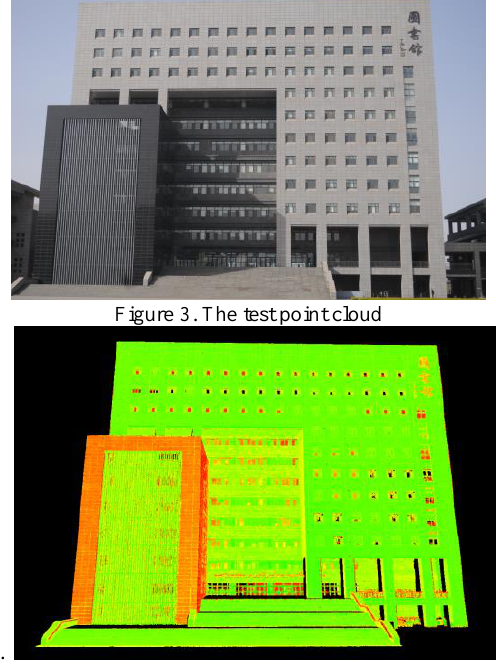
Figure 4. The test point cloud